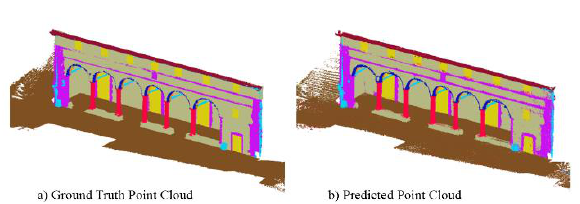
Figure 6 . Comparison between a) the Ground Truth point cloud, b) the Predicted point